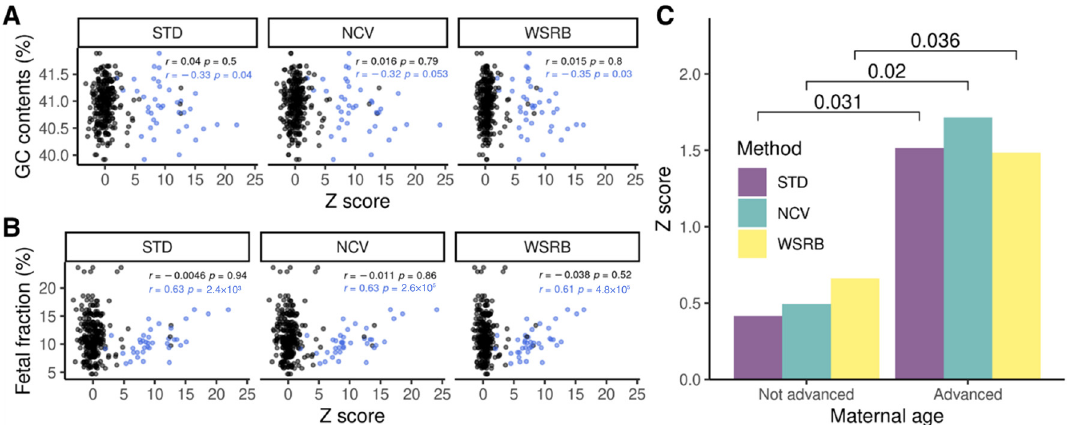
Figure 1. Correlations of fetal fraction (FF) with gestational age (GA) and body mass index (BMI) in the reference set ( n = 1698). ( A ) Boxplots of FF (%) by GA (weeks). The middle point represents the average of FF. p -value is given at the top of the figure. ( B ) Mean of FF (%) by BMI. According to the BMI value, samples are divided into four groups: underweight (<18.5), healthy (18.5–25), overweight (25–30), and obese ( ≥ 30). * p < 0.05, ** p < 0.01, and **** p < 0.0001. FFs were calculated using the weighted rank selection criterion (WRSC) model in SeqFF.